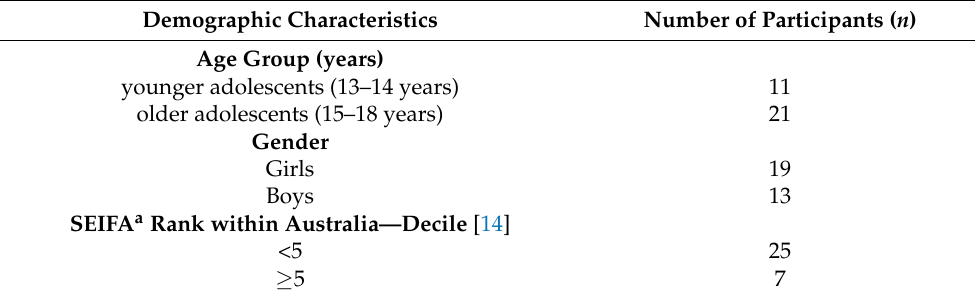
Table 2. Demographic information of focus group participants ( n = 32)